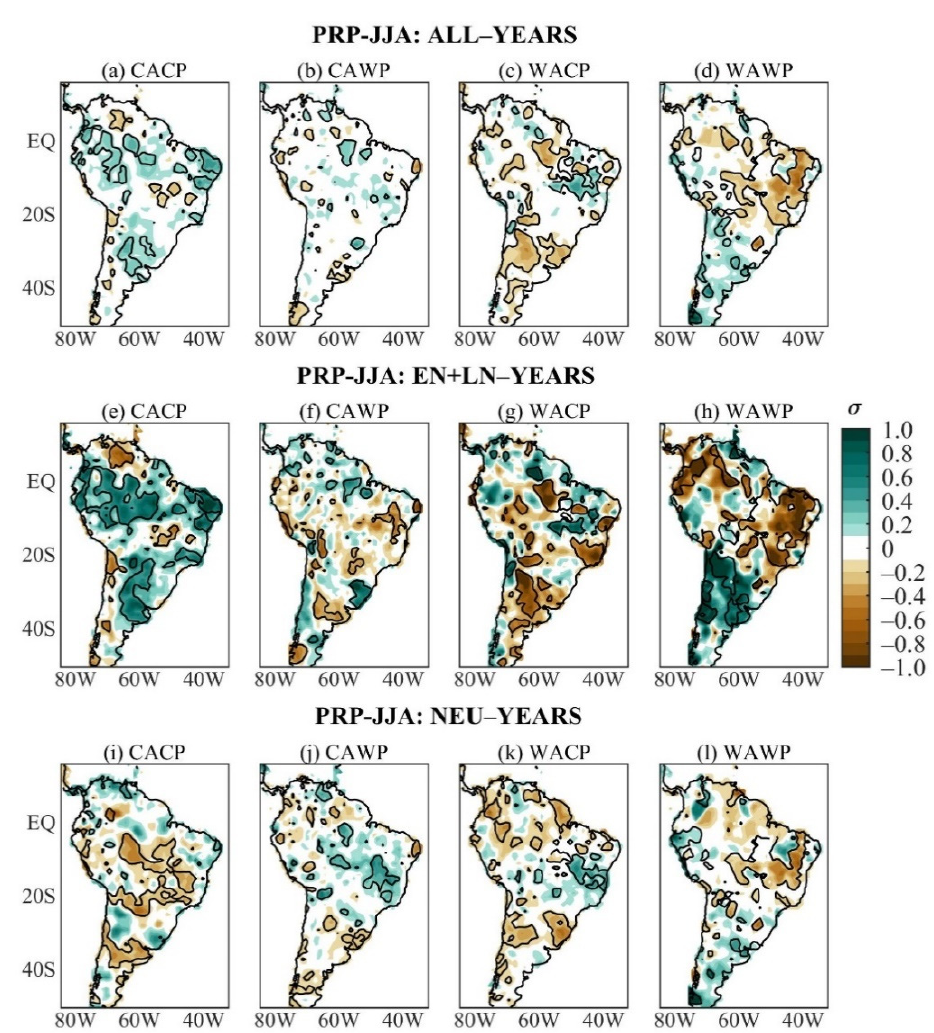
Figure 2. Austral winter PRP anomaly composites of ALL-years during the: ( a ) CACP, ( b ) CAWP, ( c ) WACP, and ( d ) WAWP mean states; of EN + LN-years during the: I CACP, ( e ) CACP, ( f ) CAWP, ( g ) WACP, and ( h ) WAWP mean states; of NEU-years during the: ( i ) CACP, ( j ) CAWP, ( k ) WACP, and ( l ) WAWP mean states. Continuous contours encompass the significant anomalies at a 90% confidence level using the Student’s t -test. The symbol σ above the colour bar means standard